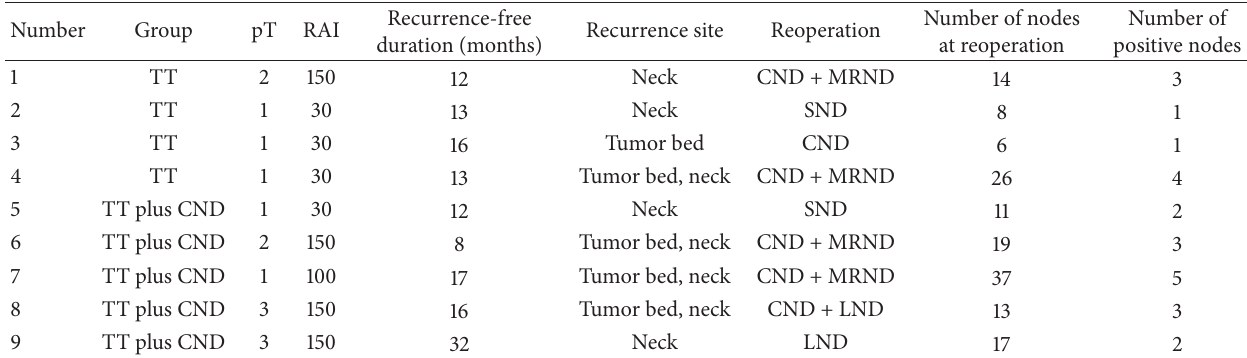
Table 3: Characteristics of the patients with